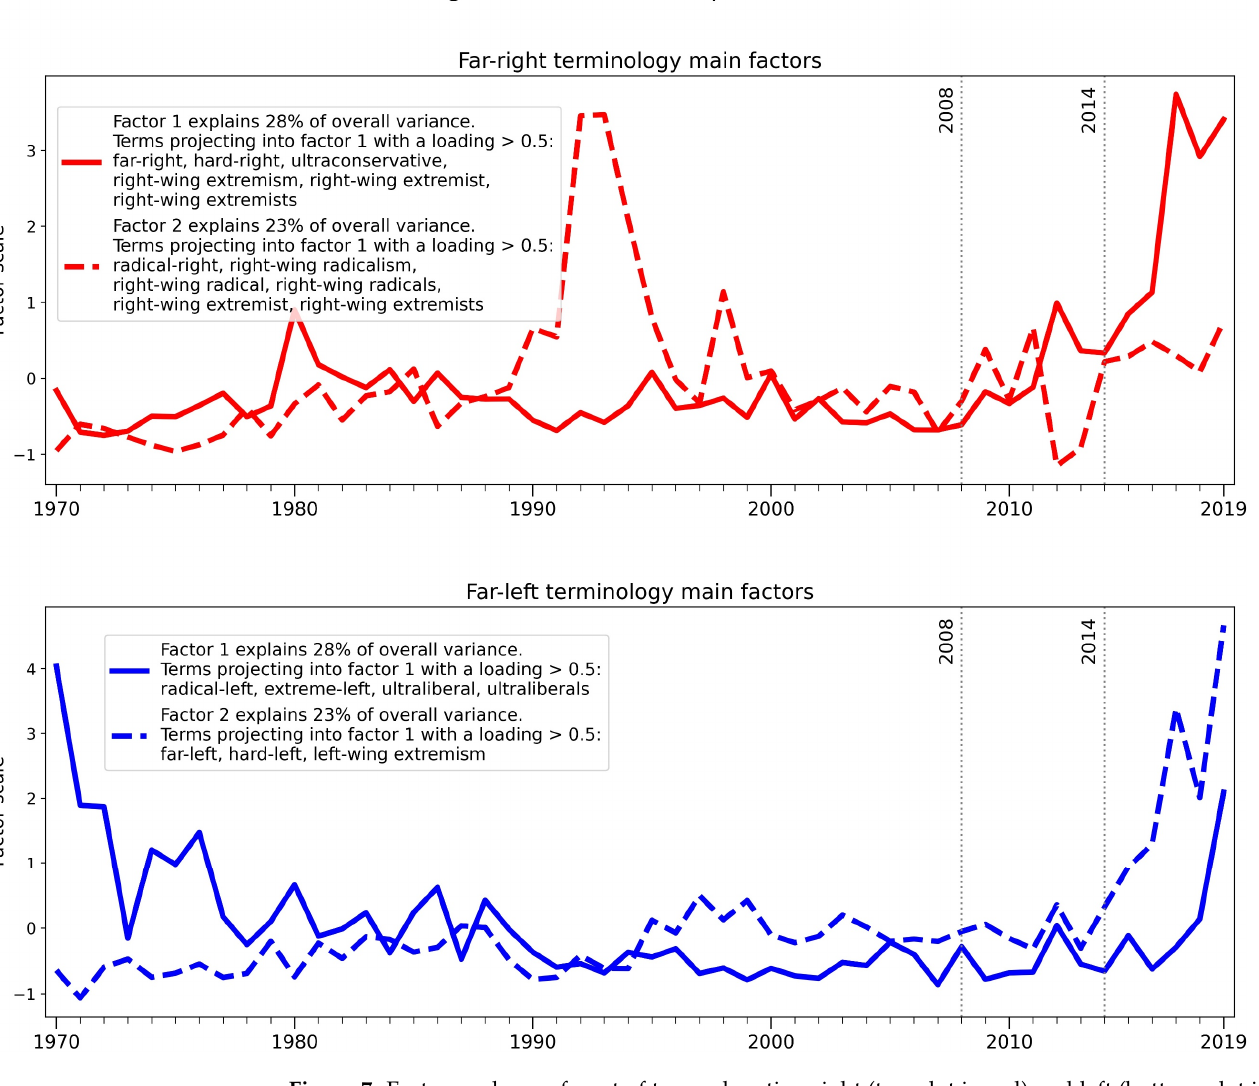
Figure 7. Factor analyses of a set of terms denoting right (top plot in red) and left (bottom plot in blue) political extremism in news media articles from The New York Times and The Washington Post . The vertical dotted lines highlight the years 2008 and 2014.